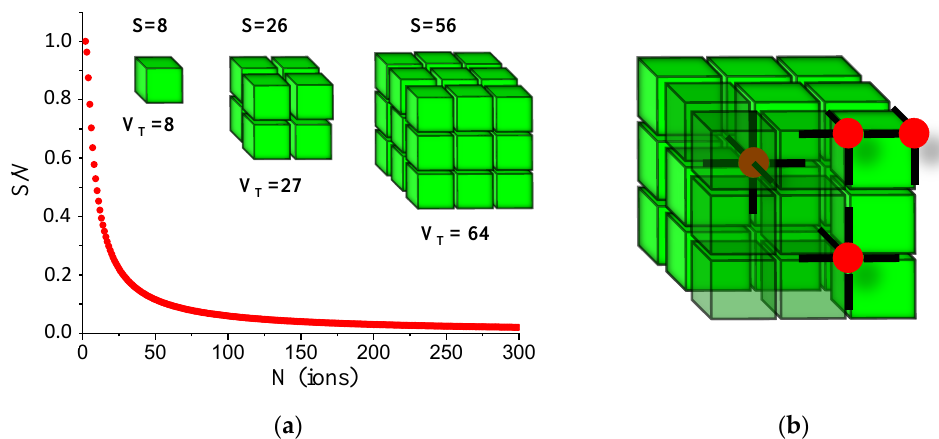
Figure 3. ( a ) Ratio of surface to volume ions in a cubic lattice, for very small nanoparticles (NPs) surface ions can amount up to large percentages of the totality and ( b ) corner, edge, surface and inner ions with different coordination numbers.